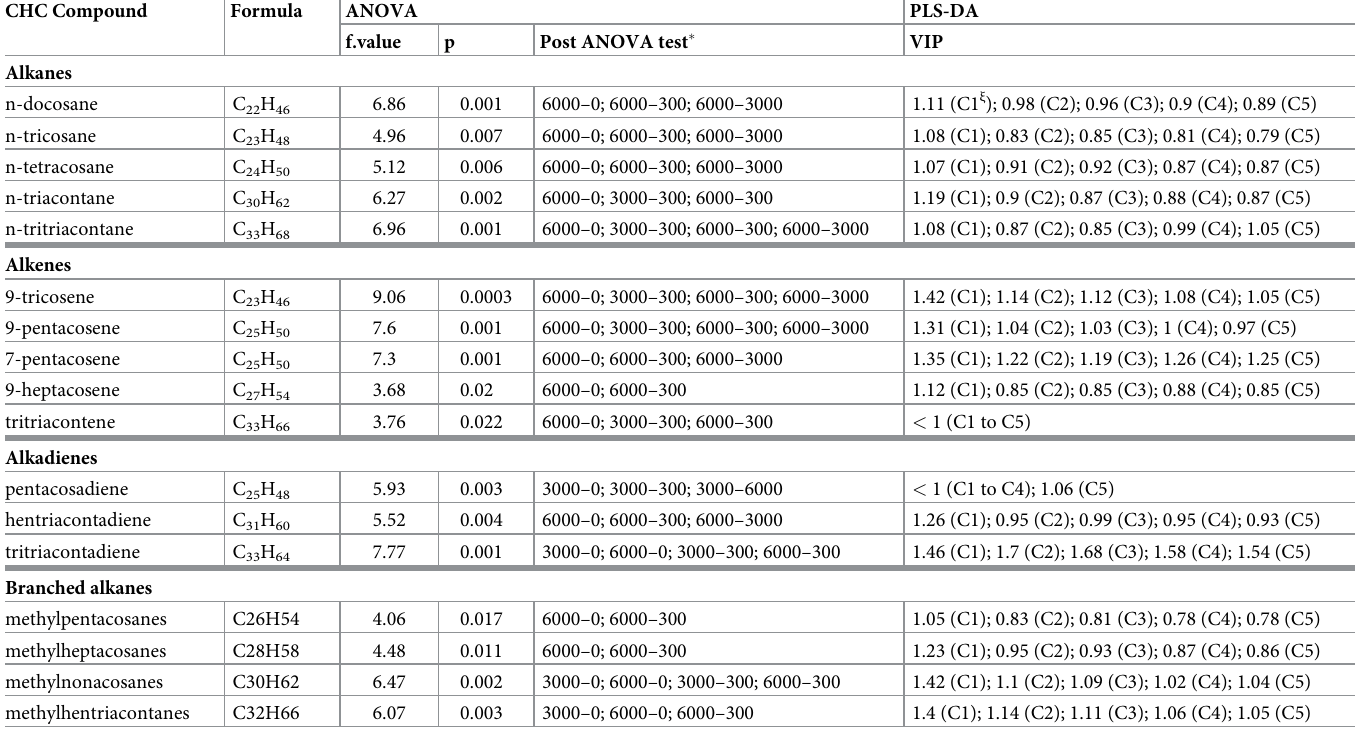
Table 2. Results for individual CHC in experiment I (honeybees were fed on EOEb at different doses: 0, 300, 3000, 6000 ppm) where significant differences were found related to the doses by the analysis of variance (ANOVA, GLM) and variable importance in projection (VIP scores are reported when > 1) from a PLS-DA.